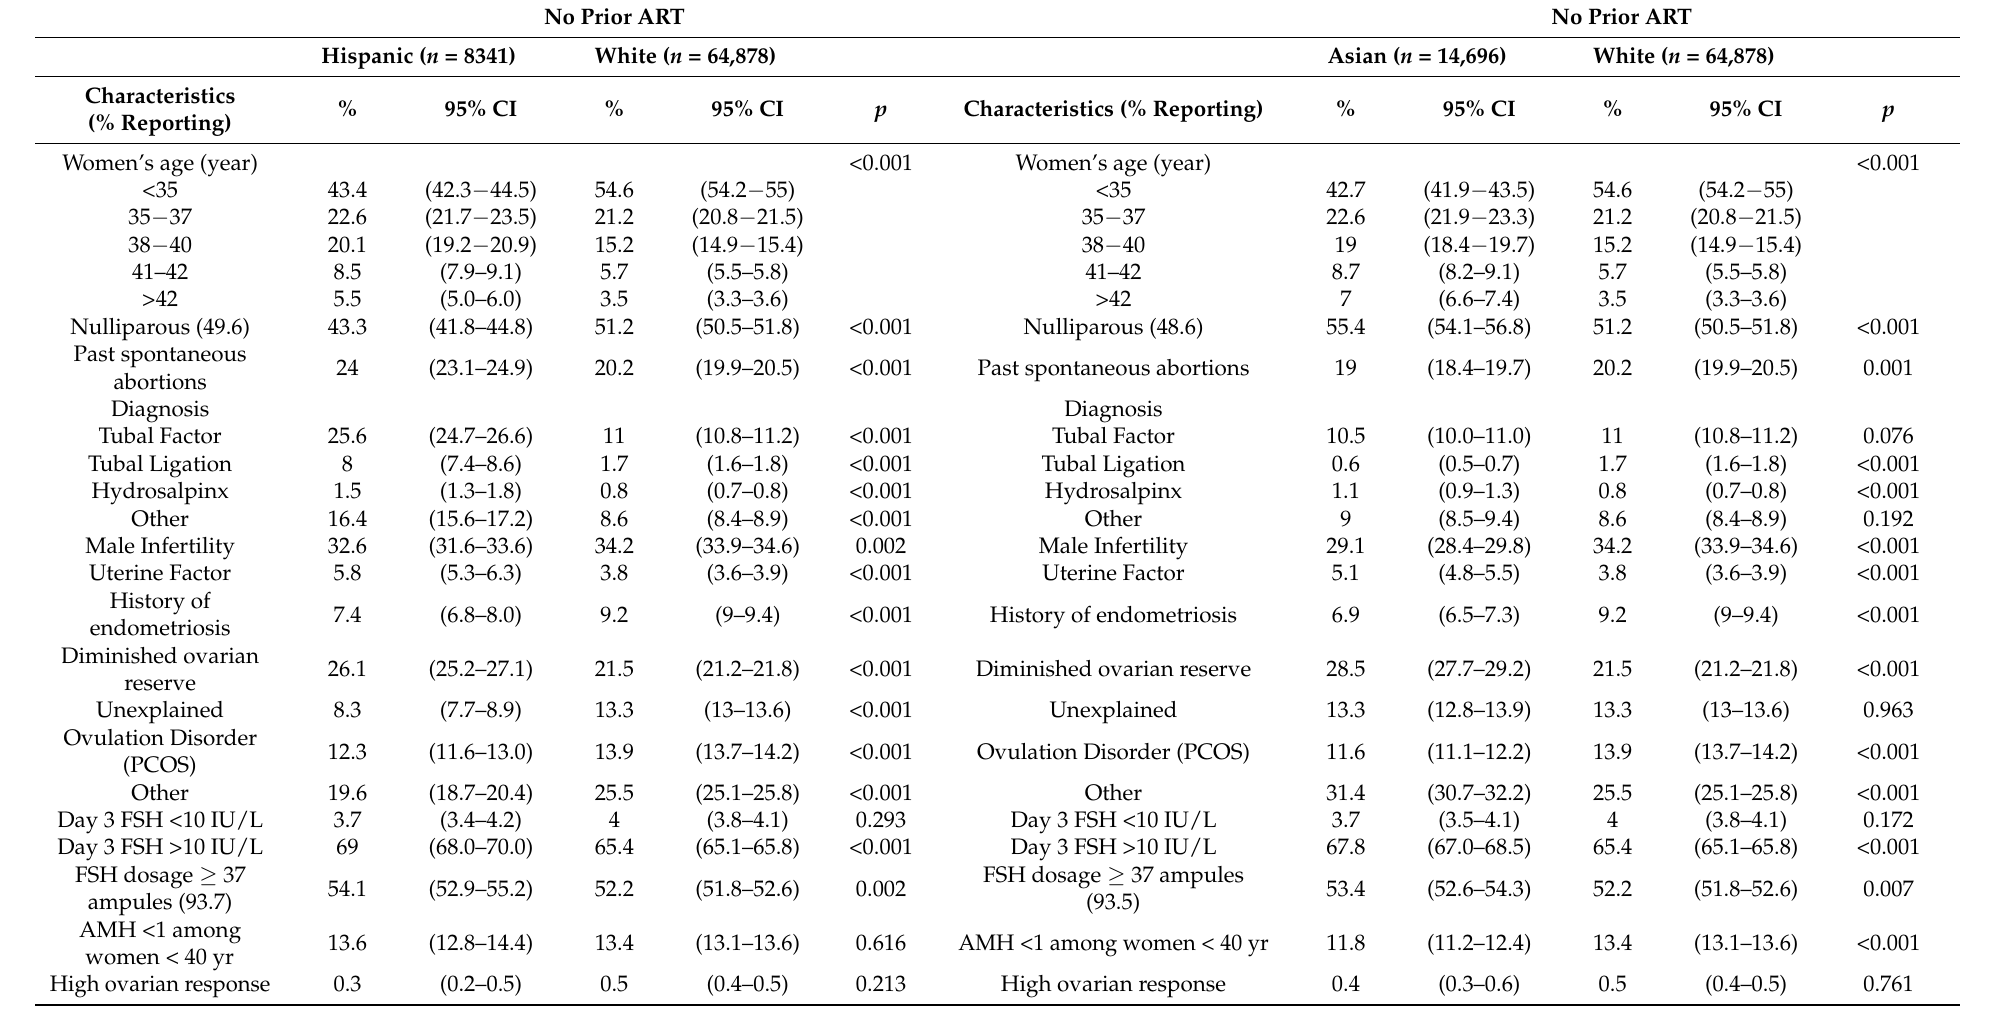
Table 1. Baseline characteristics, treatment, and outcomes for fresh, nondonor cycles among Hispanic, Asian, and white women with no prior